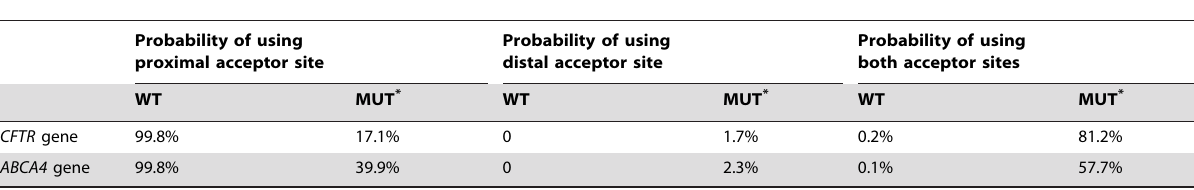
Table 2. In silico analysis using BayNAGNAG